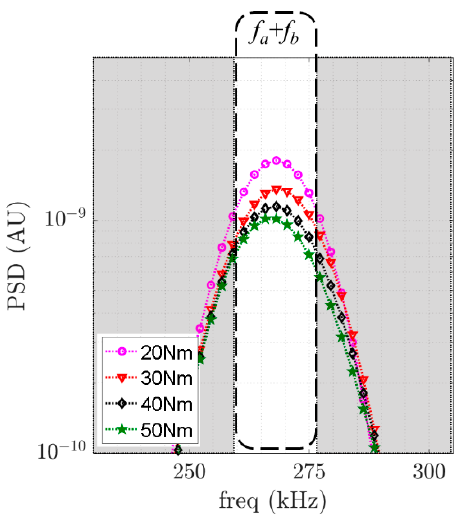
Figure 8. PSD comparison between four different levels of applied torque at the sum frequency component.